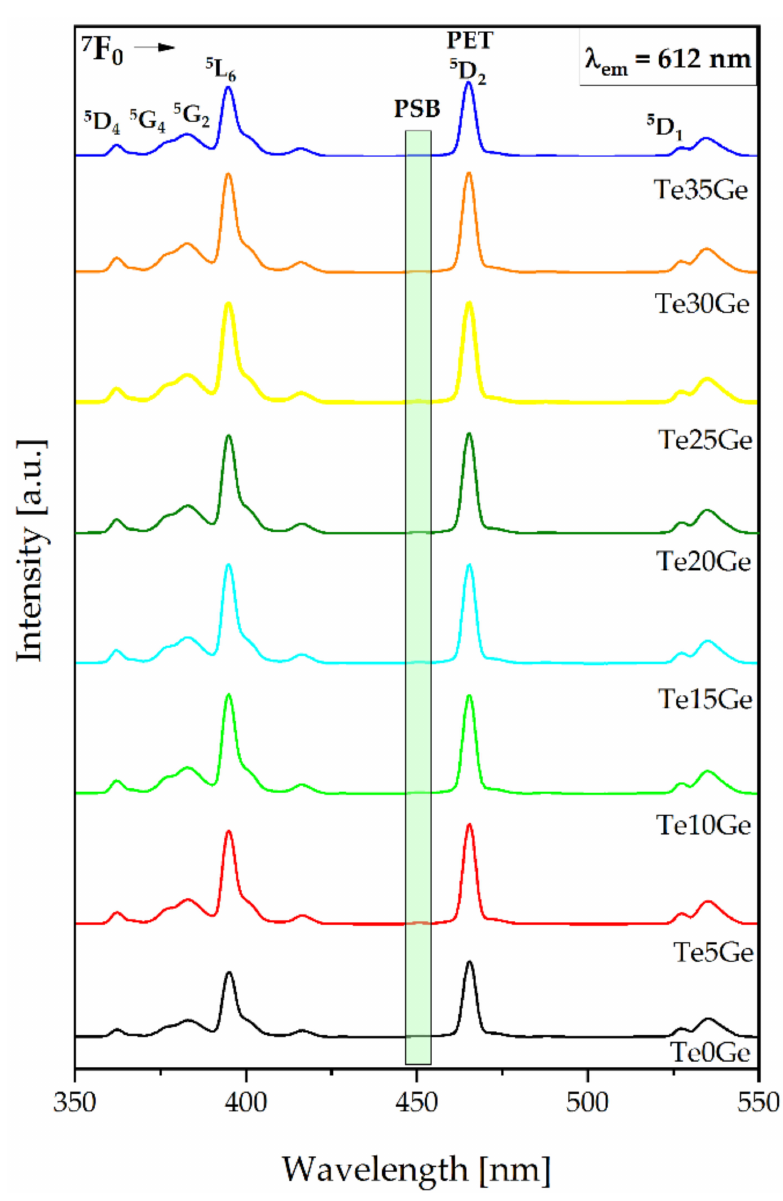
Figure 9. PLE spectra of Eu 3+ -doped glasses with various TeO 2 /GeO 2 molar